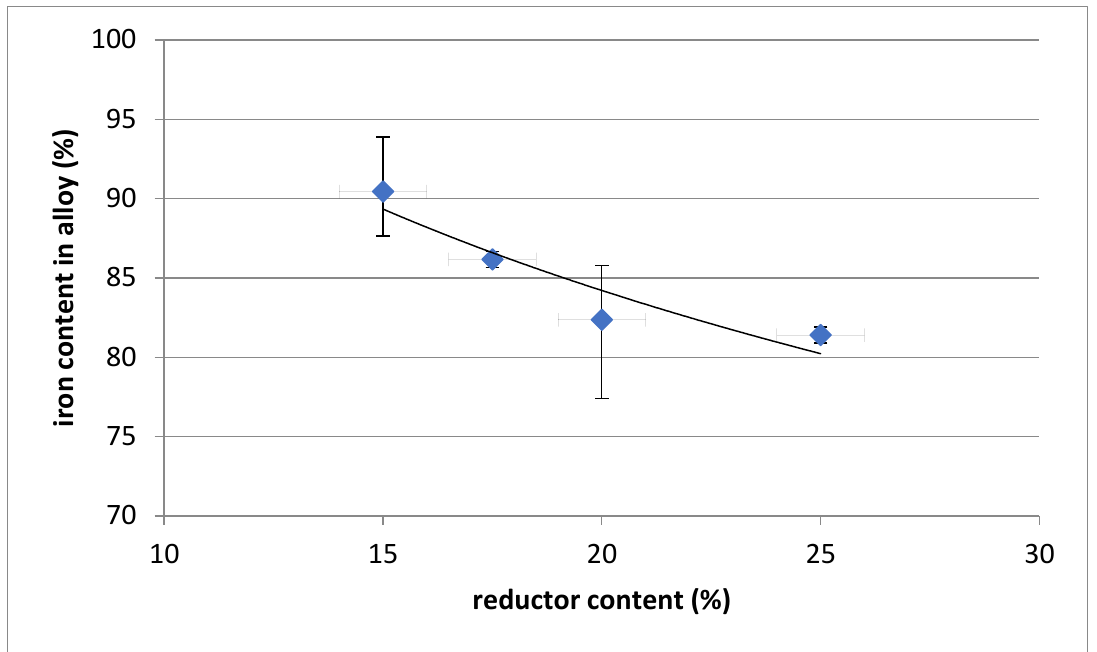
Figure 4. Dependence of iron content in the alloy on the content of reductor.